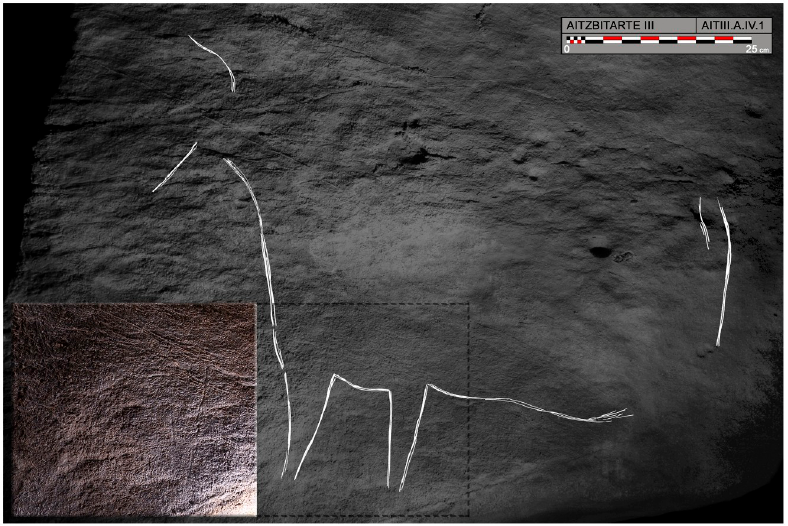
Fig 9. Tracing and detailed photograph of the front legs of the aurochs A.IV.1, engraved at the end of the left- hand wall in Aitzbitarte III (O. Rivero and D. Garate).